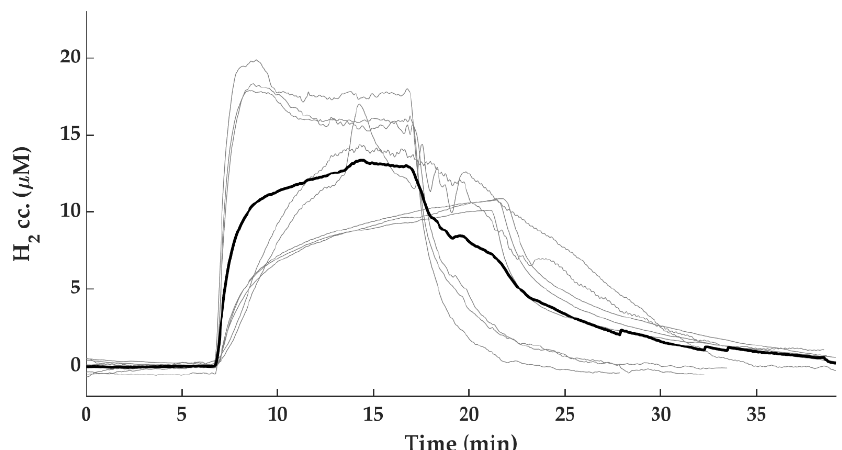
Figure 4. Cerebrocortical H 2 concentration changes during 2.1% H 2 ventilation. H 2 gas was ventilated to the animals ( n = 8 trials from n = 3 piglets) until steady state H 2 levels were reached at 10–15 min after initiation of H 2 ventilation (grey lines—individual traces, bold black line—mean).